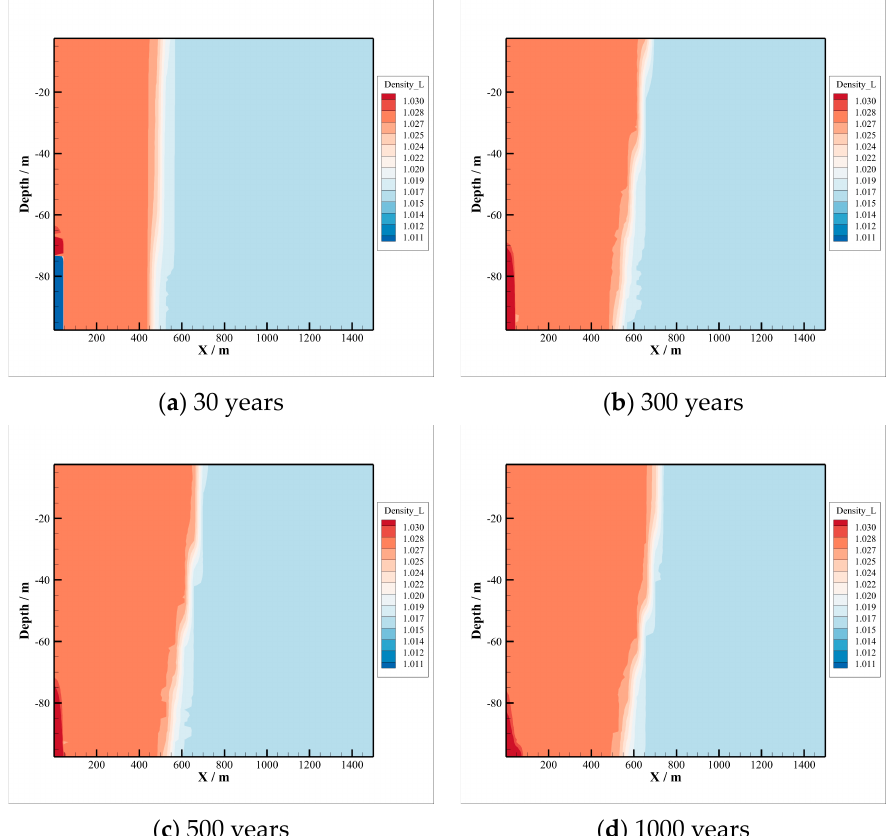
Figure 3. Variations in brine density.